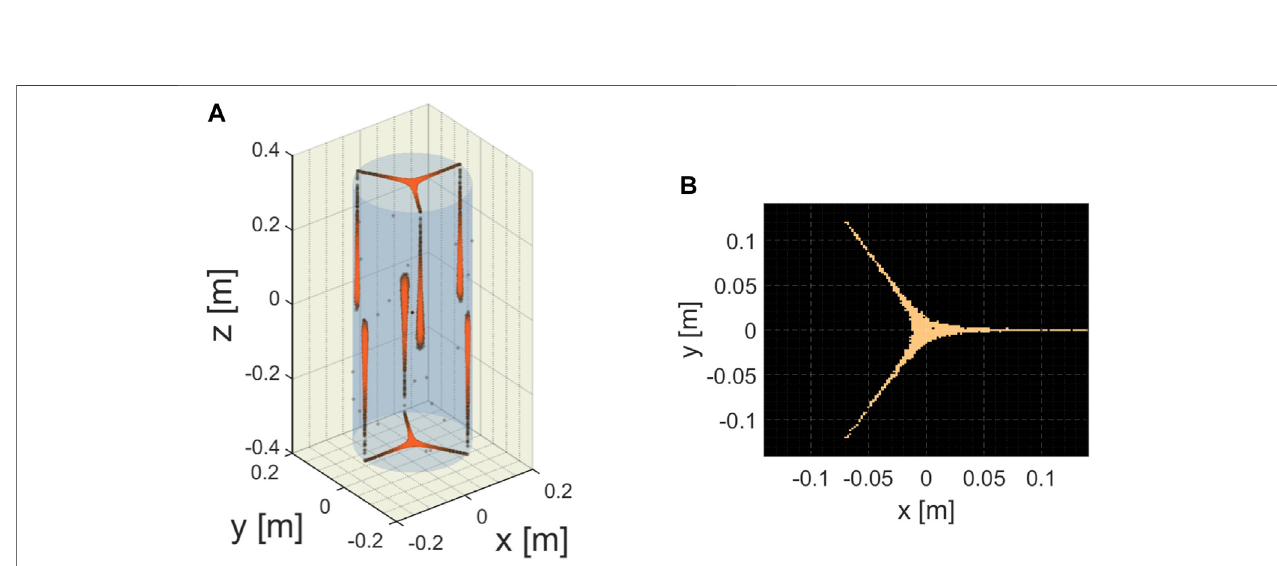
FIGURE7|(A) 3Dlost electron maskon chamber wall duetoPANDORAmagneticbranchesdisposition; (B) detail oflostelectron maskontheinjection end-plate ( z = 350 mm, see reference system of Figure 3 ).